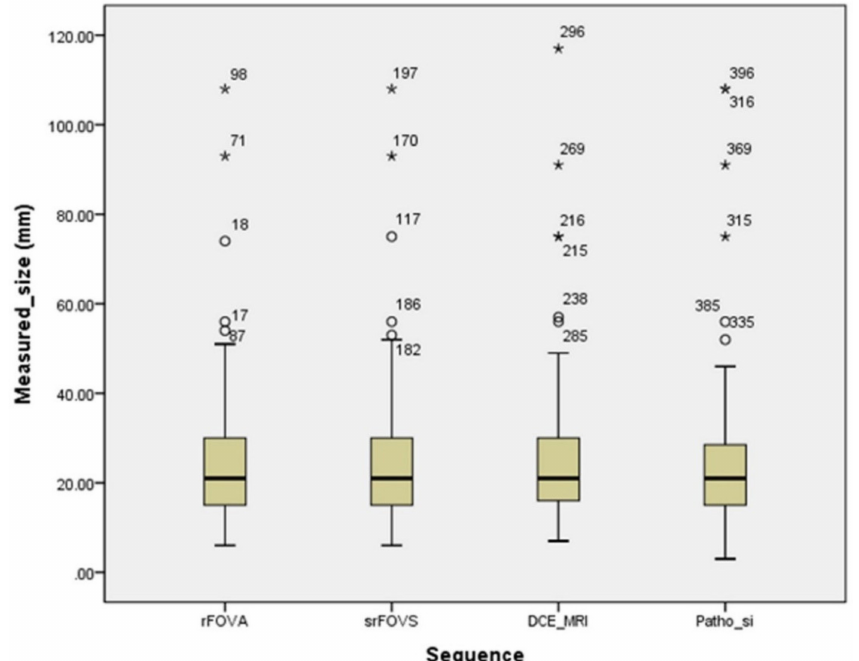
Figure 4. Boxplot shown the agreement among the size measurements of the index tumor on the srFOVS, rFOVA-1000, and DCE MRI and pathological tumor size. Rectangular box: interquartile range which contains the middle 50% of the measured size. Lines extend from the upper and lower edge of the box: whiskers which are no greater than 1.5 times of the interquatile range. Circle: out values greater than 1.5 times of the interquartile range. Stars: extreme values greater than 3 times of